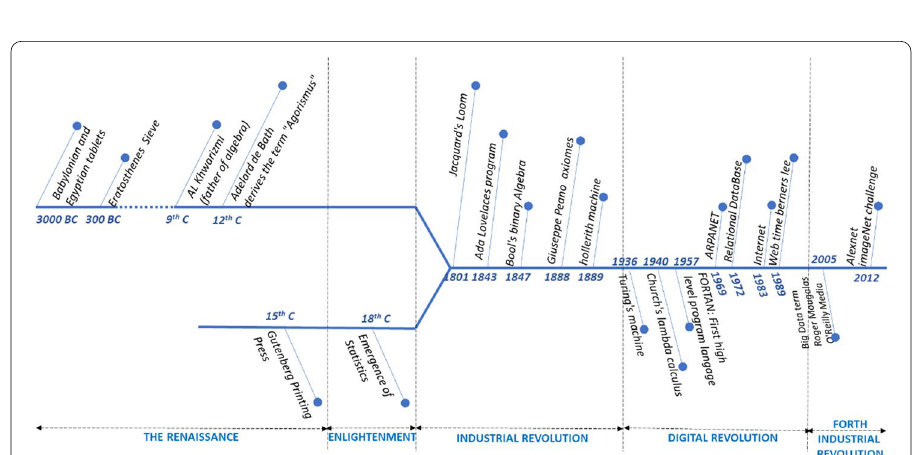
Fig. 3 “Data” and “Algorithms” evolution with key